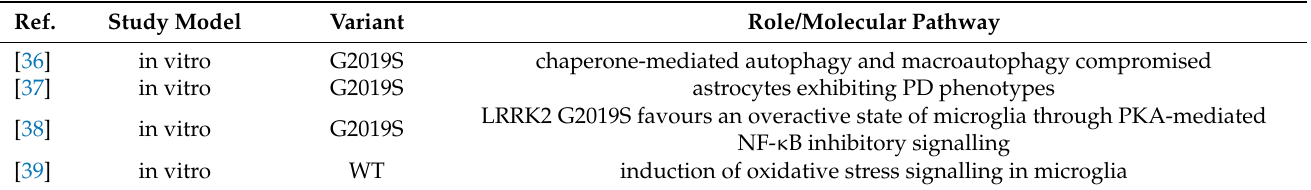
Table 4. Studies investigating the contribution of glial cells to neurotoxicity associated with LRRK2.